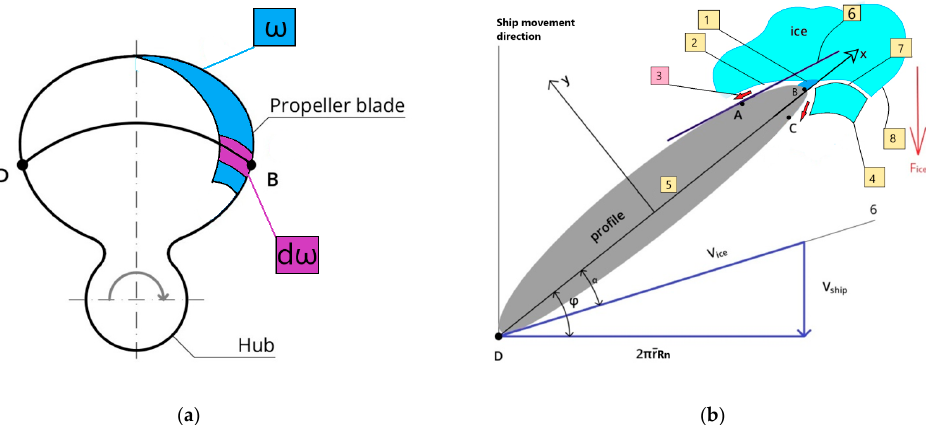
Figure 2. ( a ) Loaded area on the propeller blade; ( b ) The process of ice damage by a blade leading edge for ice milling at positive attack angle (V.A. Belyashov, N. Soininen, B. Veitch, Andryushin) [4–8]. DB—cylindrical section of propeller blade; AB—contact zone from the suction side; BC—contact zone from the pressure side; ω —length of contact zone along leading edge; d ω —element of contact zone; 1—ice crushing zone; 2—ice channel; 3—ice powder; 4—split fragment; 5—profile chord; 6—line of attack angle; 7—splitting crack; 8—ice free surface; α —attack angle; ϕ —pitch angle; V ship —ship speed; V ice —ice contact speed; n —propeller speed; r —relative radius of propeller; R —propeller radius; F ice —backward axial ice force (see below).